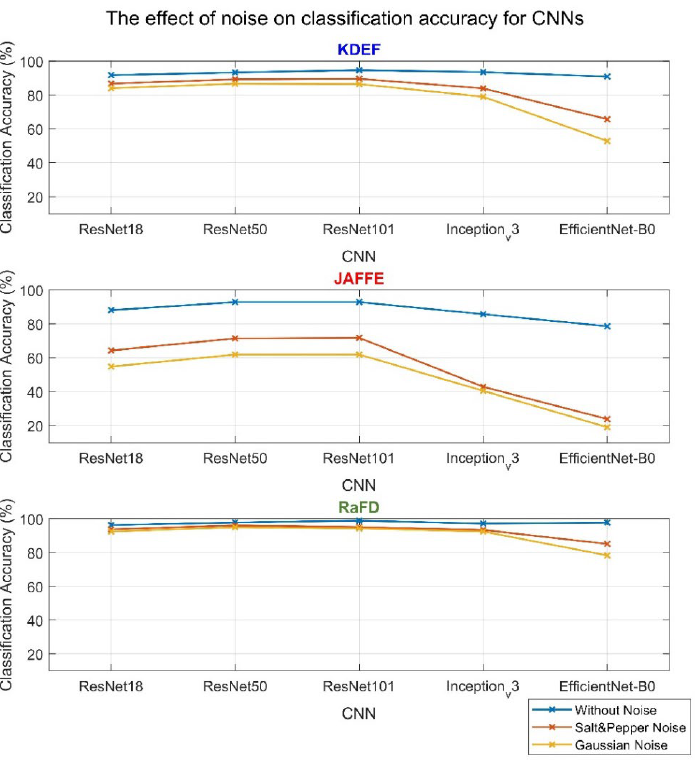
Figure 6. Classification accuracy per CNN for each database, with the test performed in clear images (blue line), in images with salt and pepper noise (red line), and in images with Gaussian noise (yellow line), with SVM classifier. The training was performed in clear images.